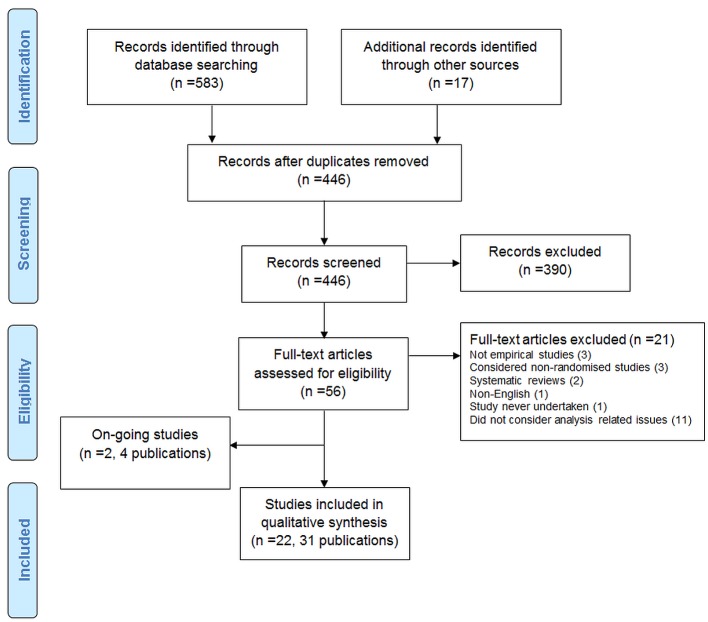
PRISMA flow diagram.